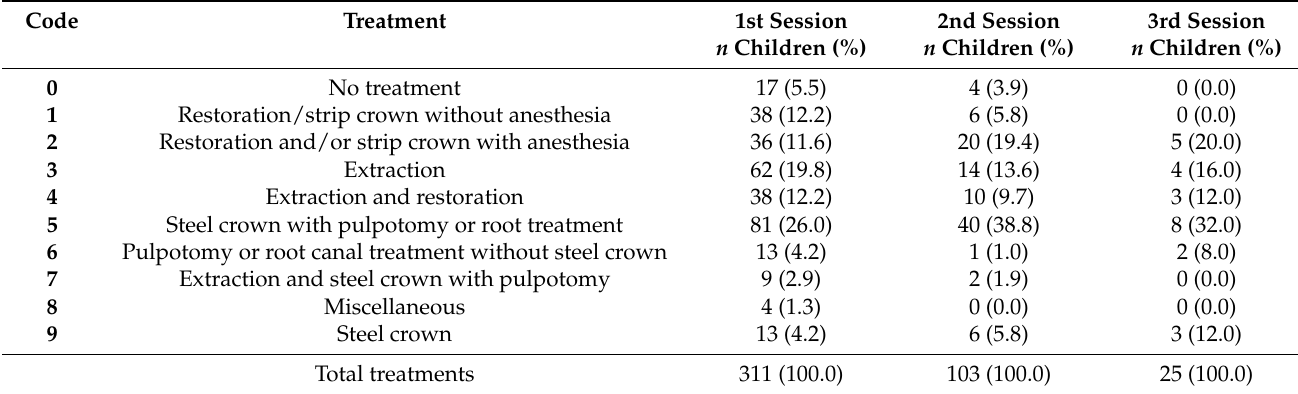
Table 1. Type of dental treatment of the 1st, 2nd or 3rd treatment session, with number of children ( n ) and percentage (%).